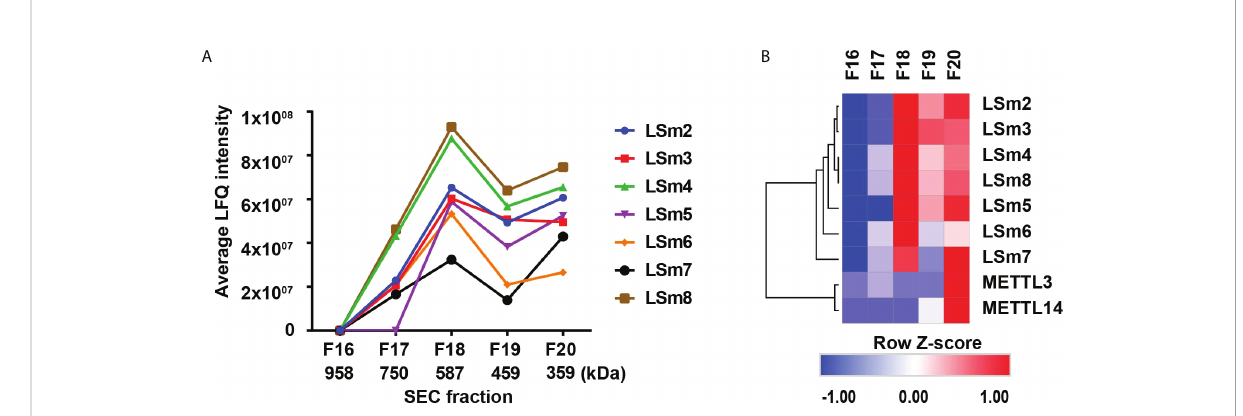
FIGURE 7 Detection of nuclear LSm2-8 complex in HepaRG lysates. (A) Native nuclear extracts from HepaRG cells fractionated by Superdex 30 size exclusion chromatography (SEC). Fractions # 17-20 analysed by LC MS/MS. LSm2-8 complex proteins eluted in fractions #17-20, peaking in fraction 18, with an estimated native molecular mass of 587 kDa. (B) Hierarchical clustering analyses of select proteins from SEC fractions # 17- 20. Color scale represents Z-scored LFQ